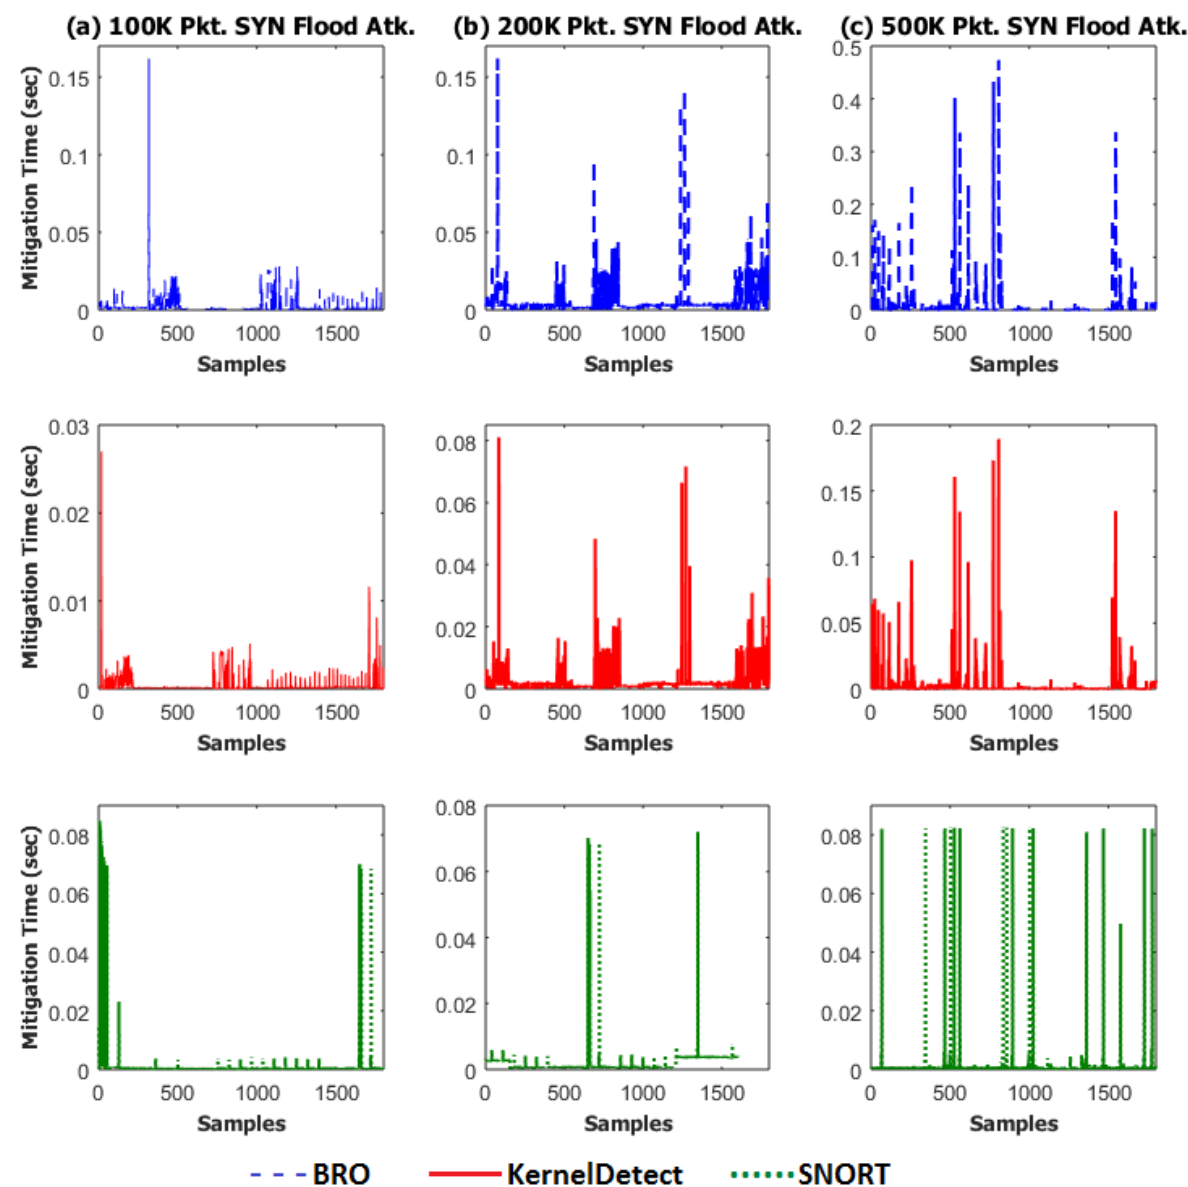
Figure 8. Threat mitigation time for each IDS under 100K, 200K and 500K SYN flagged packet DoS attack using a 10 second